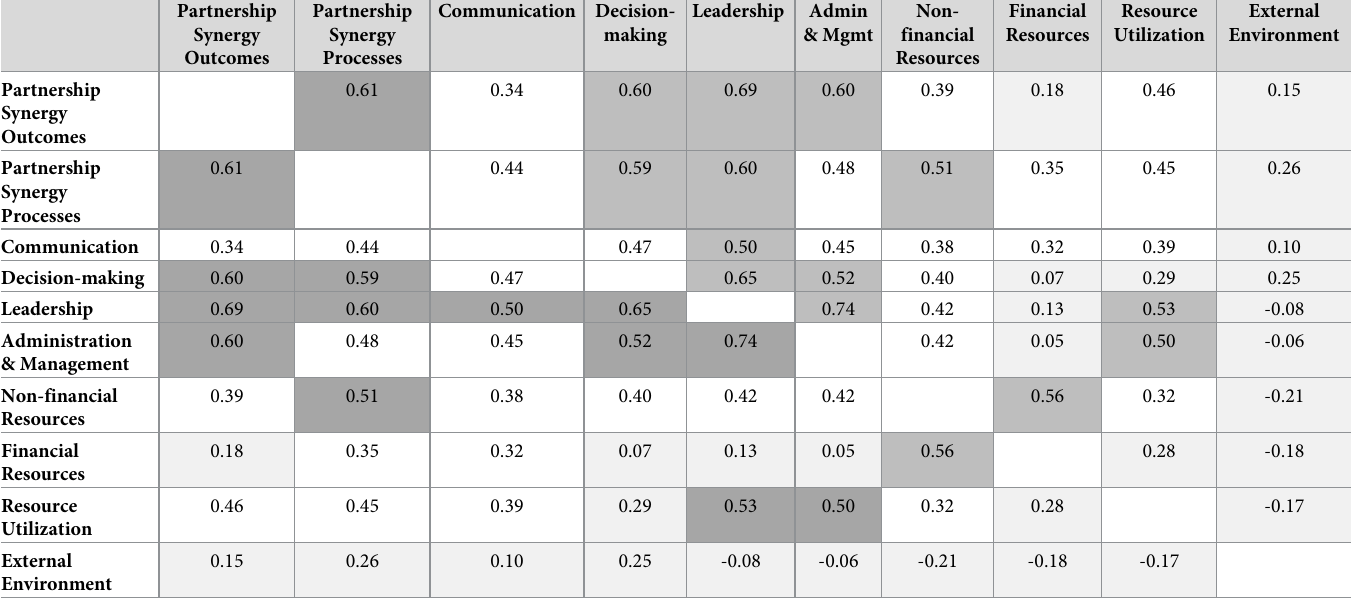
Table 5. Spearman rank correlations between partnership synergy outcomes, partnership synergy processes, and the different dimensions of partnership function- ing ( N = 54). Values shaded in light grey denote weak correlations, in dark grey–strong correlations. Partnership